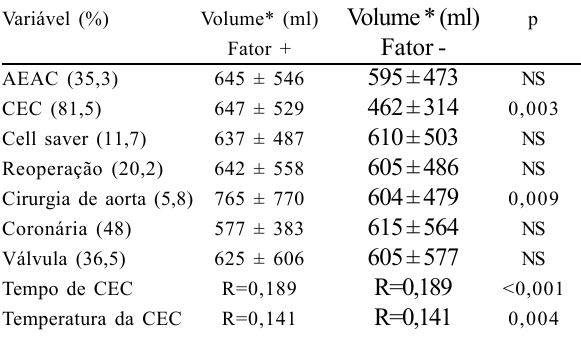
Tabela 4. Fatores de risco intra-operatórios estudados através de análise univariada.